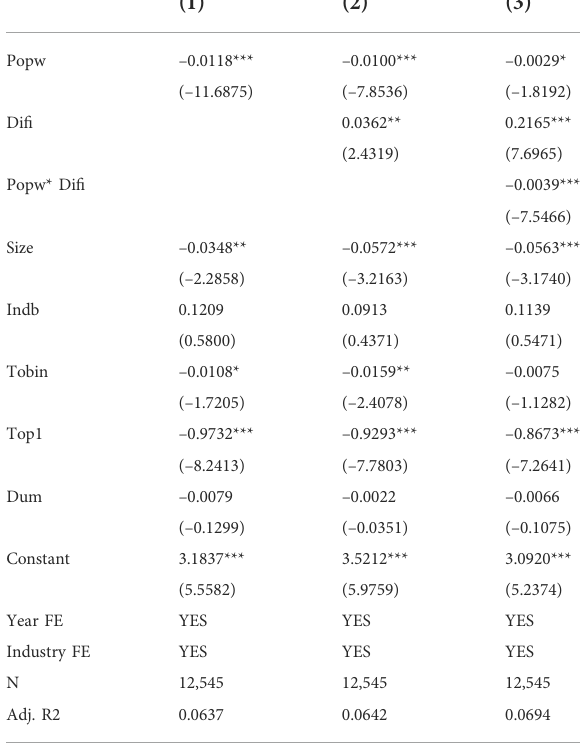
TABLE 4 Moderating effect of digital fi